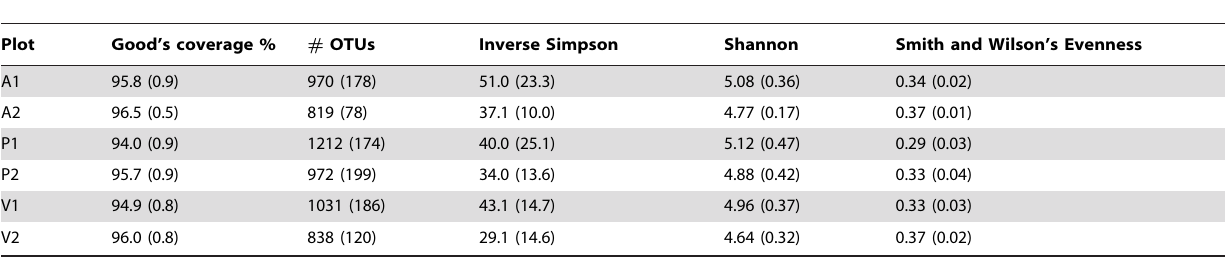
a Shown are the mean and (sd) of each statistic calculated for 5 sequencing samples per plot.